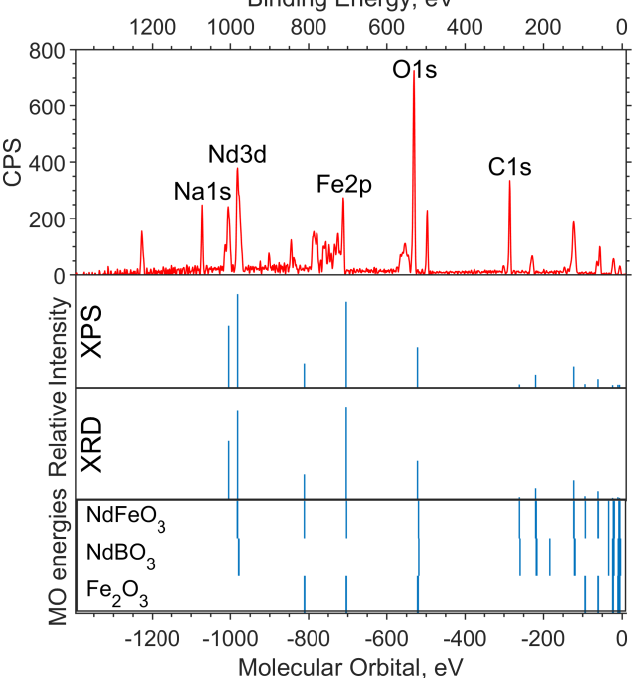
Figure 1. Overview of the XPS spectrum of the NdFe (1 − x) Co x B oxide powders with x = 0, the theoretical “stick” “spectrum”, and the MO energies of the model compounds.